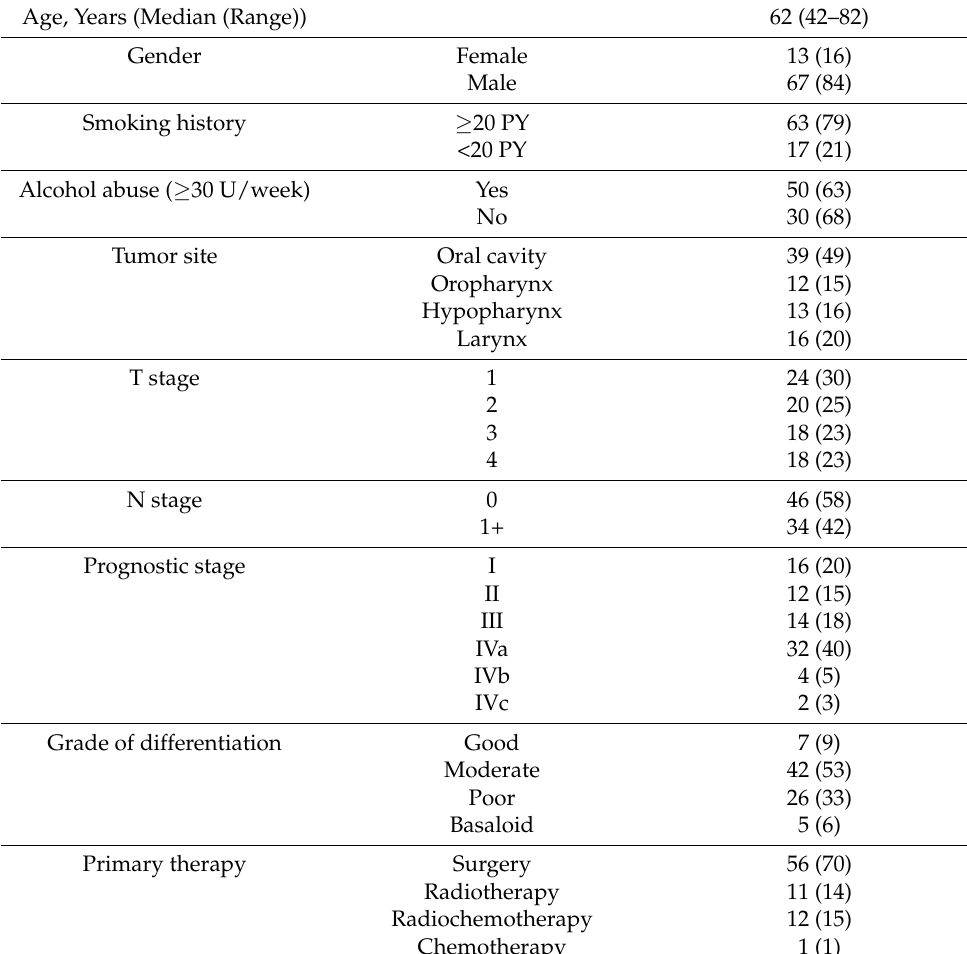
Table 1. Clinicopathological